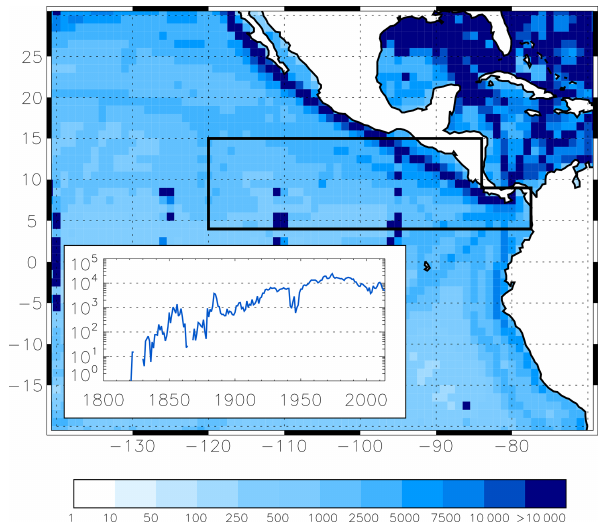
Figure 4. Number of wind direction observations in a 1 × 1 grid (May to November) and the 1800–2014 period available in ICOADS 3.0. Black contour indicates the area selected to com- pute the CHOCO-D index (4–15 ◦ N; 120–80 ◦ W). The graph at the bottom-left shows the time evolution of the cumulative number of wind direction observations inside the selected domain not consid- ering data taken at moored buoys (note the logarithmic y scale).